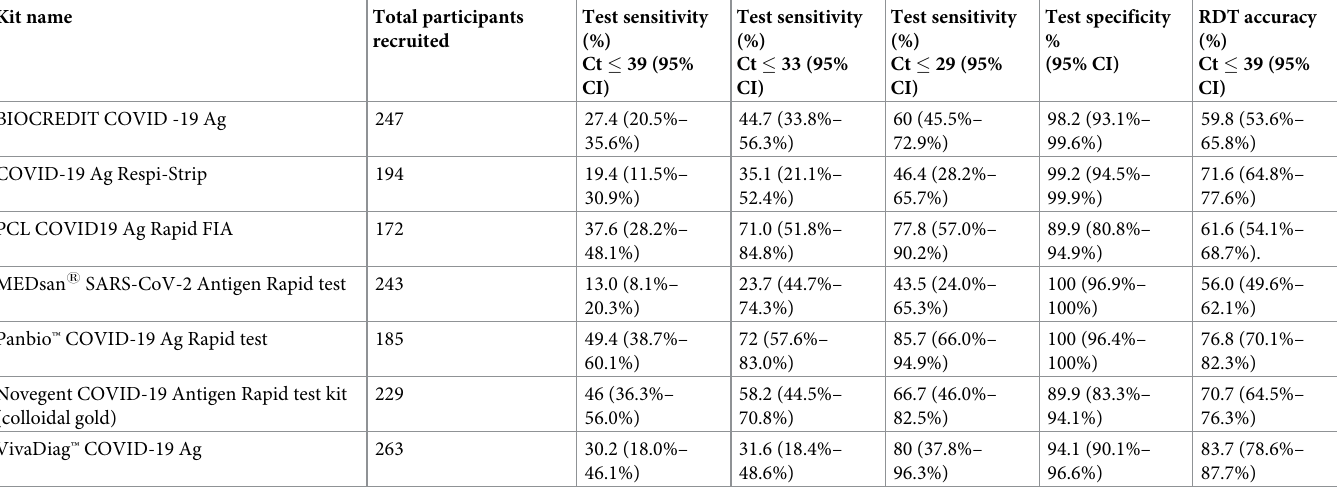
Table 2. Field performance of 7 antigen RDTs for the diagnosis of SARs-CoV-2 virus in Uganda. Kit